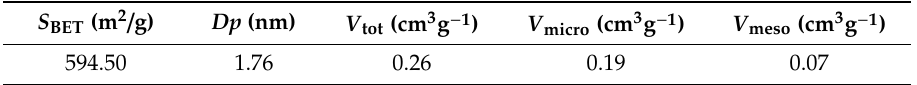
Figure 3. Nitrogen adsorption-desorption isotherm of PKSBC at 77 K ( a ) and pore size distribution curves of PKSBC ( b ). Table 1. Textural properties of